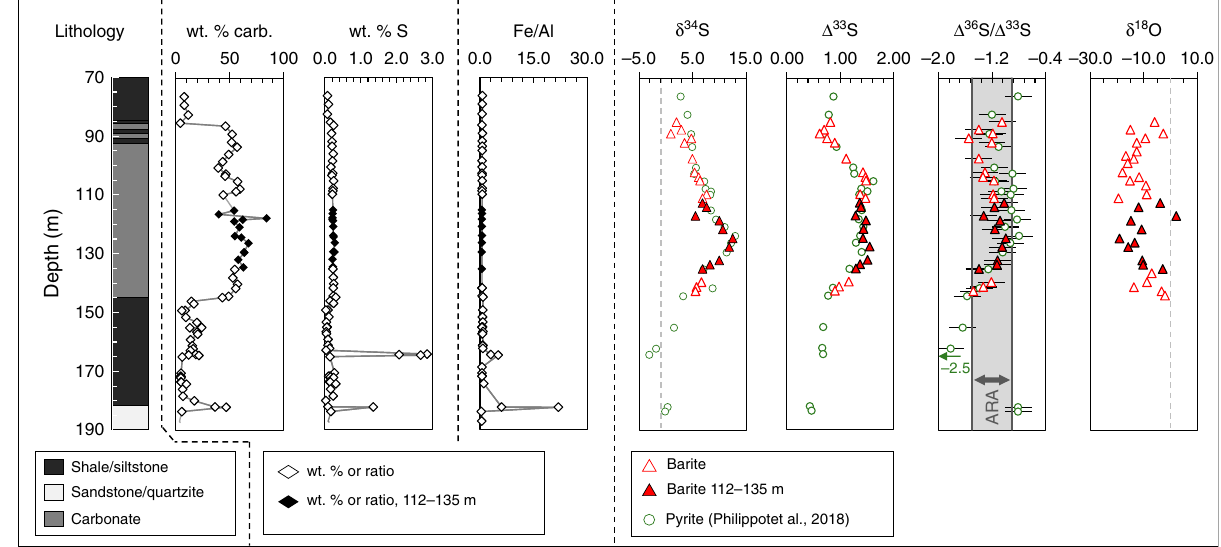
Fig. 2 The stratigraphic distribution of barite stable isotope data ( δ 34 S, Δ 33 S, Δ 36 S and δ 18 O), carbonate abundance (wt. % carb.), total sulfur (wt. % S), and Fe/Al mass ratios are plotted by their depth in drill core TCDP3 of the lowermost Kazput Formation. Pyrite isotope and weight percent sulfur data are from 16 , while Fe/Al mass ratios are from 31 . Isotope data analytical uncertainties (2 σ ) are ± 0.1 ‰ , ± 0.01 ‰ , ± 0.2 ‰ and ± 0.4 ‰ for δ 34 S, Δ 33 S, Δ 36 S and δ 18 O, respectively, and are shown as error bars or are smaller than the symbols. The ARA on the Δ 36 S/ Δ 33 S plot is the Archaean Reference Array, as in Fig. 3. The fi lled symbols are from the core depth interval 112 – 135 m with speci fi c sulfur-oxygen isotope correlations that are discussed in the text and shown in Fig. 3. Figure source data are included in the Source Data fi